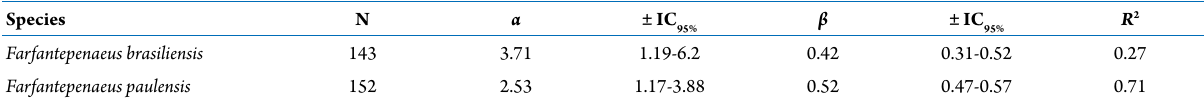
Table 2. Estimated parameters of the relationships between individual wet weight (g) - cephalothorax length (mm) of Farfantepenaeus brasiliensis and F. paulensis caught in April 2019 in Rocha lagoon, for both sexes together and for males and females separately. Intercept (α), slope (β), limits of 95% confidence intervals of α and β (± IC95%), and coefficient of determination ( R 2 ) of the model. Species Sex N α ± IC